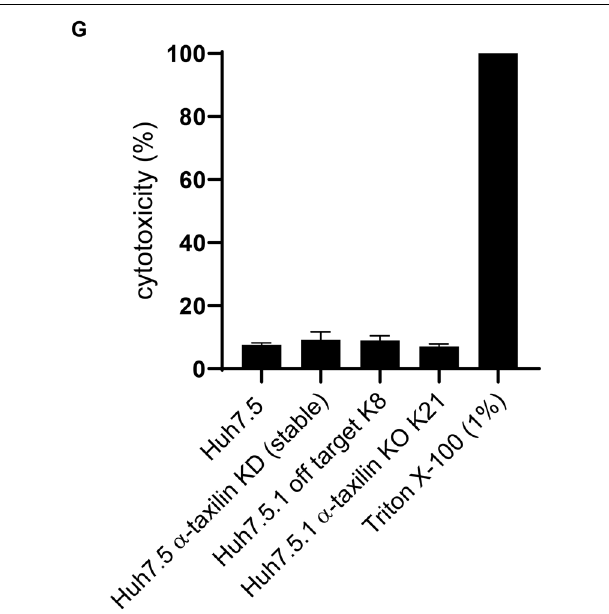
FIGURE 1 | Reduced amounts of the TfR in α -taxilin knockdown (KD) and α -taxilin knockout (KO) cells. (A) (Left) Western blot analysis of cellular lysates derived from Huh7.5 cells transfected with an α -taxilin-specific siRNA (50 nM) or scrRNA (50 nM) (control). 24 h after siRNA transfection, the cells were transfected with pDest26-TXLNA (1 µ g) or pUC18 (1 µ g) (control) to rescue the α -taxilin KD. The cells were analyzed 72 h after siRNA transfection using α -taxilin- and TfR-specific antibodies. Total protein staining served as a loading control (lower panel). (Right) Densitometric quantification of α -taxilin and the TfR from two independent experiments. scrRNA transfected cells served as a control and were set as 1 ( n = 2; mean ± SEM). Two-tailed unpaired t -test, * p < 0.05, ** p < 0.01. (B) (Left) Western blot analysis of cellular lysates derived from Huh7.5 cells and stable α -taxilin KD Huh7.5